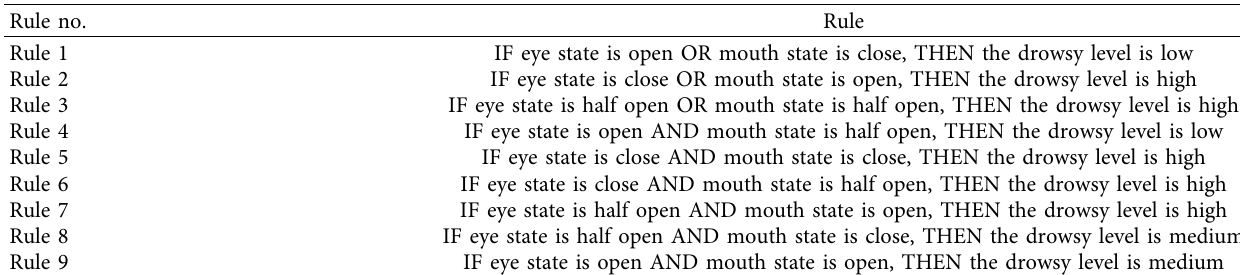
Figure 10: FIS editor showing the MF: (a) for eye state; (b) for mouth state. Table 4: Rule editor.